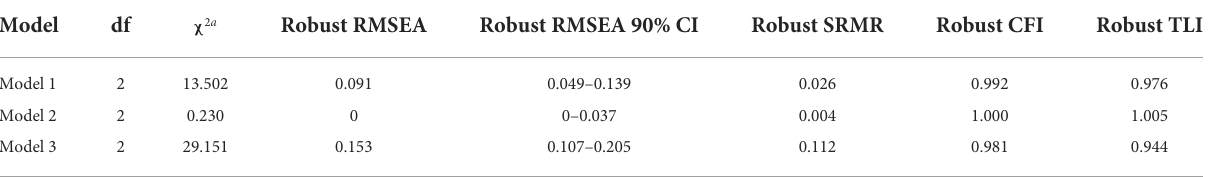
TABLE 3 Fit indices for model 1 (PNE and stress), model 2 (PNE and resilience) and model 3 (resilience and stress).